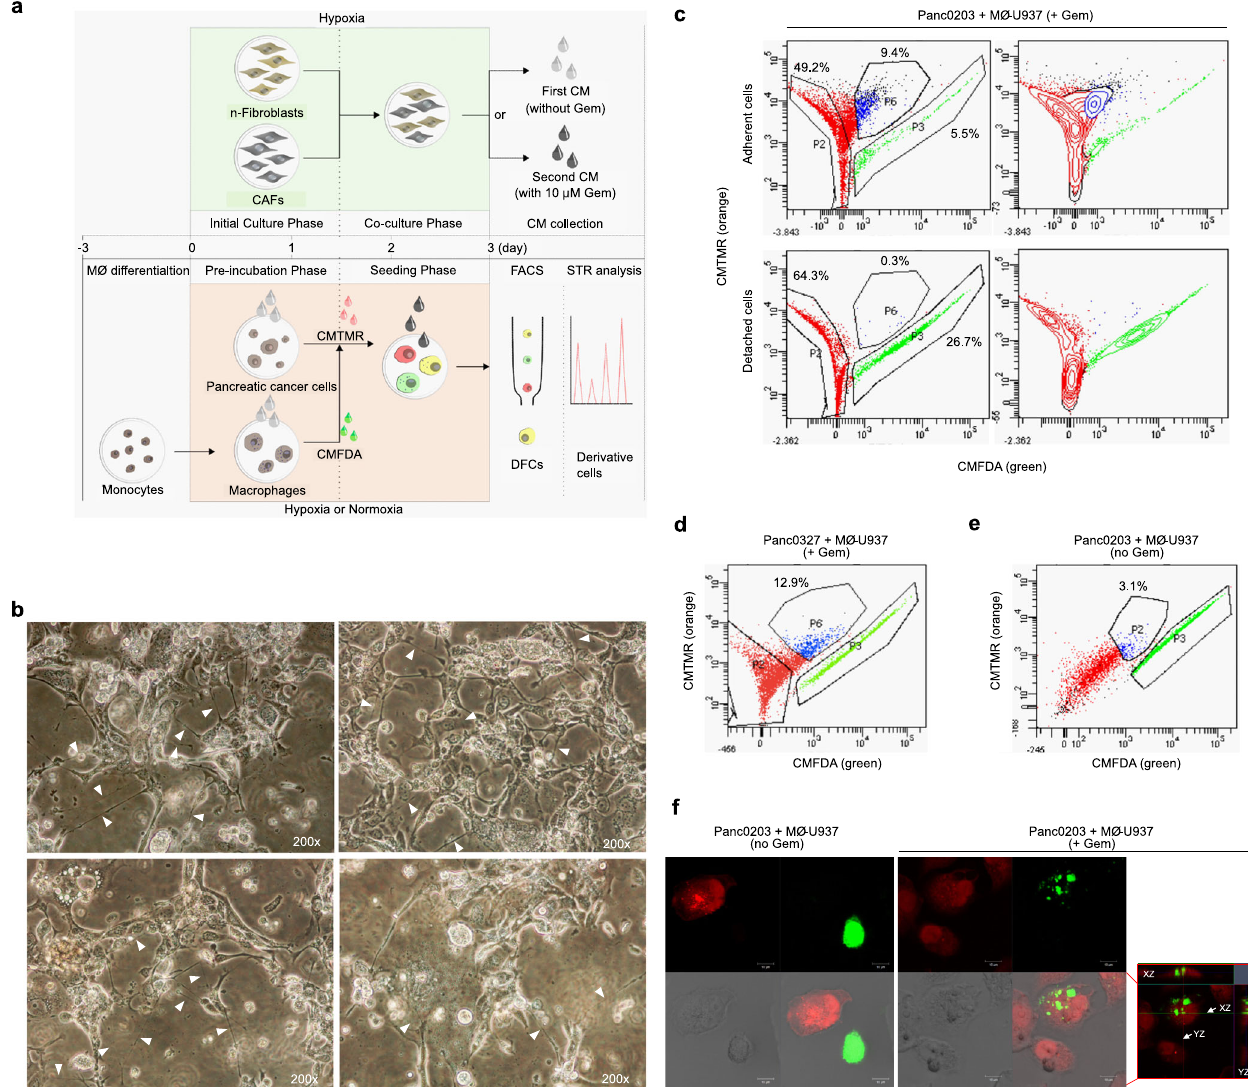
Fig. 1 In vitro TME model development and isolation of pancreatic cancer cells exhibiting direct cell-to-cell transfer. a Schematic of the TME mimic model showing steps for collecting conditioned media (CM) from human pancreatic normal fi broblasts (n- fi broblasts) co-cultured with human pancreatic cancer-associated fi broblasts (CAFs) under hypoxic only or hypoxic/gemcitabine (gem)-induced stress conditions (upper panels); and for co-culturing pancreatic cancer cells with macrophages to isolate cells exhibiting direct cell-to-cell transfer (double fl uorescent cells; DFCs) and to generate derivative cells. MØ: macrophage, CMTMR: 5-(and-6)-(((4-chloromethyl)benzoyl)amino)tetramethylr- hodamine, CMFDA 5-chloromethyl fl uorescein diacetate, FACS fl uorescence-activated cell sorting, STR short tandem repeat. b Morphological changes of total cultured cells with increased numbers of vacuoles, enlarged cytoplasm, and multiple TNTs at the end of the Seeding phase, prior to collection of the cells for FACS. Arrowheads denote TNTs. c Percentage of isolated Panc0203 CMTMR (red), MØ-U937 CMFDA (green), and DFCs (blue) detected via FACS following preparation of adherent and detached cells from total cultured cells. Detached cells represent dying cells. d , e Percentage of adherent double fl uorescent dye-positive cells (DFCs) for FACS gating in the ( d ) gemcitabine-treated TME mimic model or ( e ) normal co-culture TME condition. The percentages in the graphs indicate the percentage of adherent DFCs. + Gem; gemcitabine- treated TME mimic model, no Gem; normal co-culture TME condition. f Confocal images of single- fl uorescent dye-positive cells (SFCs) and DFCs (red box, a merged image of entire z-stack with orthogonal views in the same fi eld). Green SFCs and red SFCs in the confocal images indicate MØ-U937 CMFDA and Panc0203 CMTMR , respectively (scale bar, 10 μ